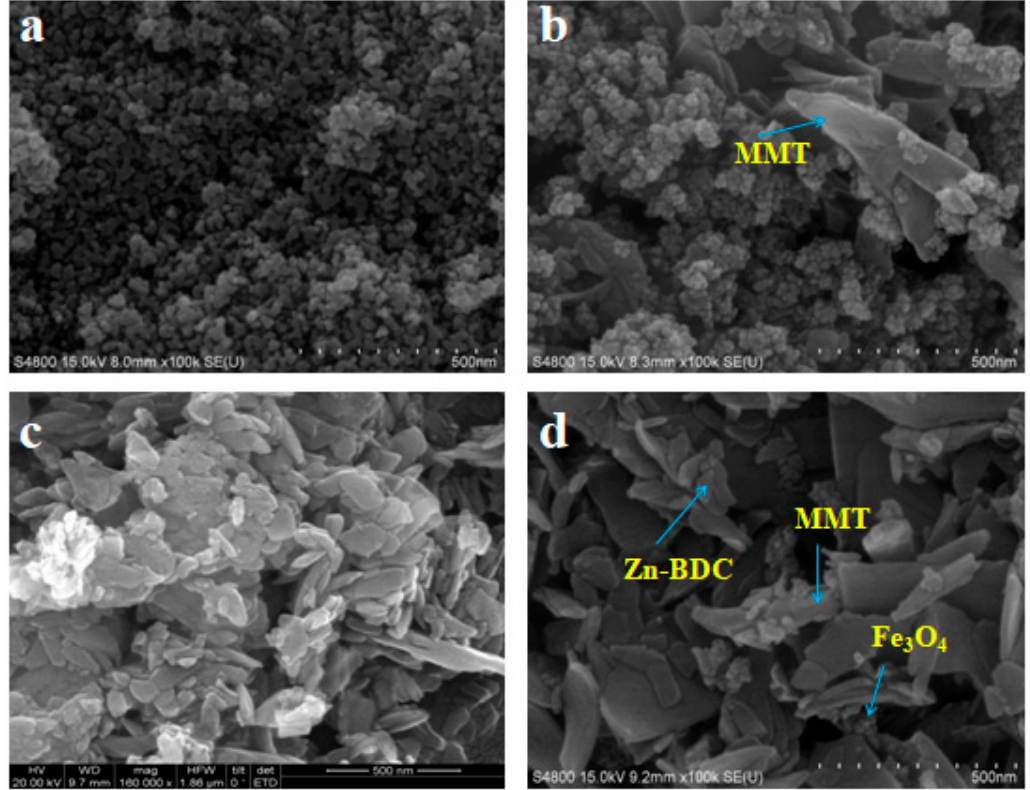
Figure 2. SEM images of ( a ) Fe 3 O 4 , ( b ) MMMT, ( c ) Zn-BDC , and ( d ) MMMT@ Zn-BDC .